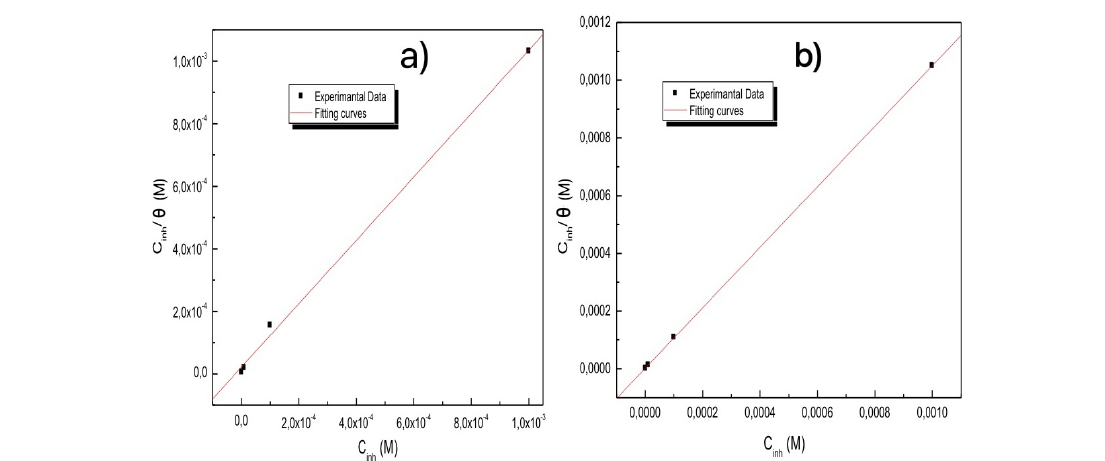
Figure 9. Langmuir isotherm adsorption curves for (a) P3 and (b) P4.